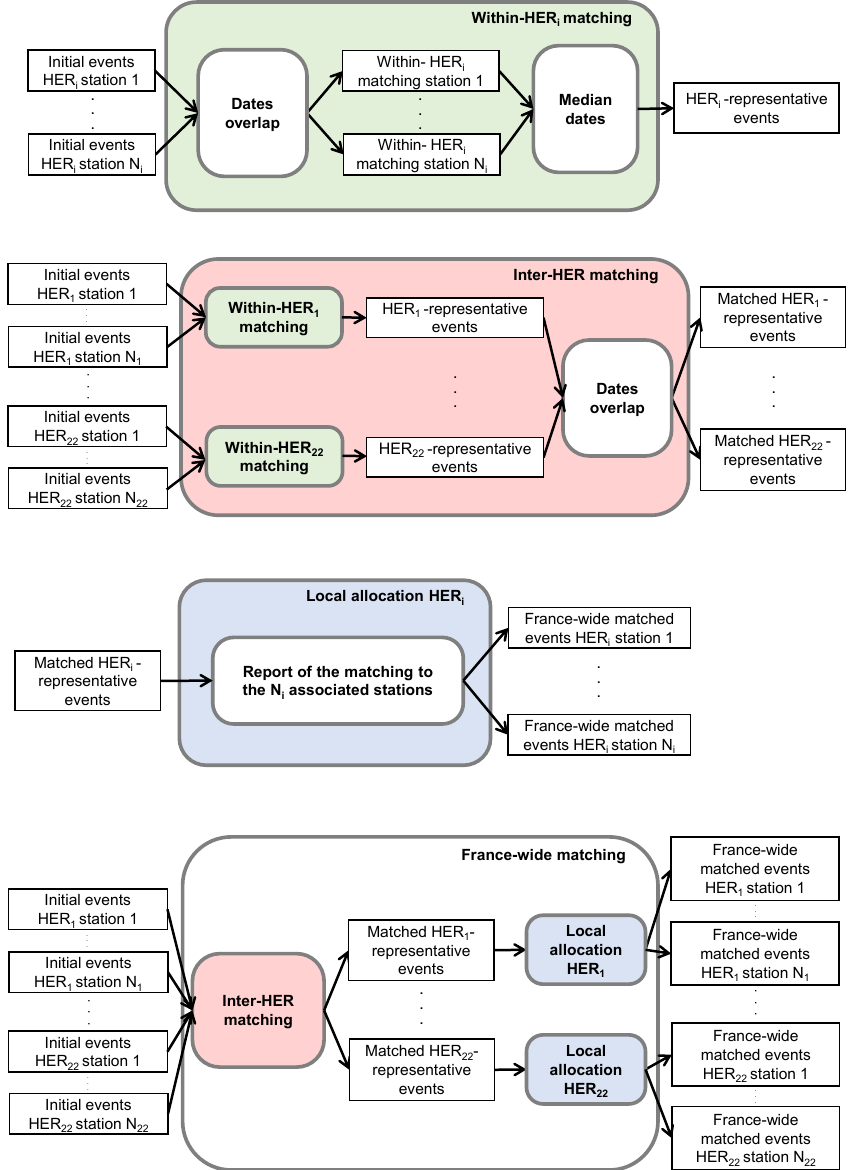
Figure 4. Synthetic diagram detailing the spatial matching procedure. The procedures described in this figure provide the different panels of Fig. 5.